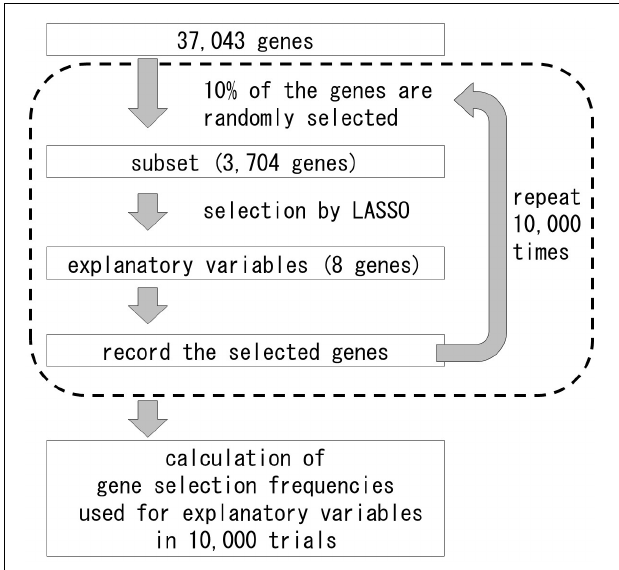
FIGURE 3 | Method to assess gene selection frequencies for the explanatory variables using LASSO.